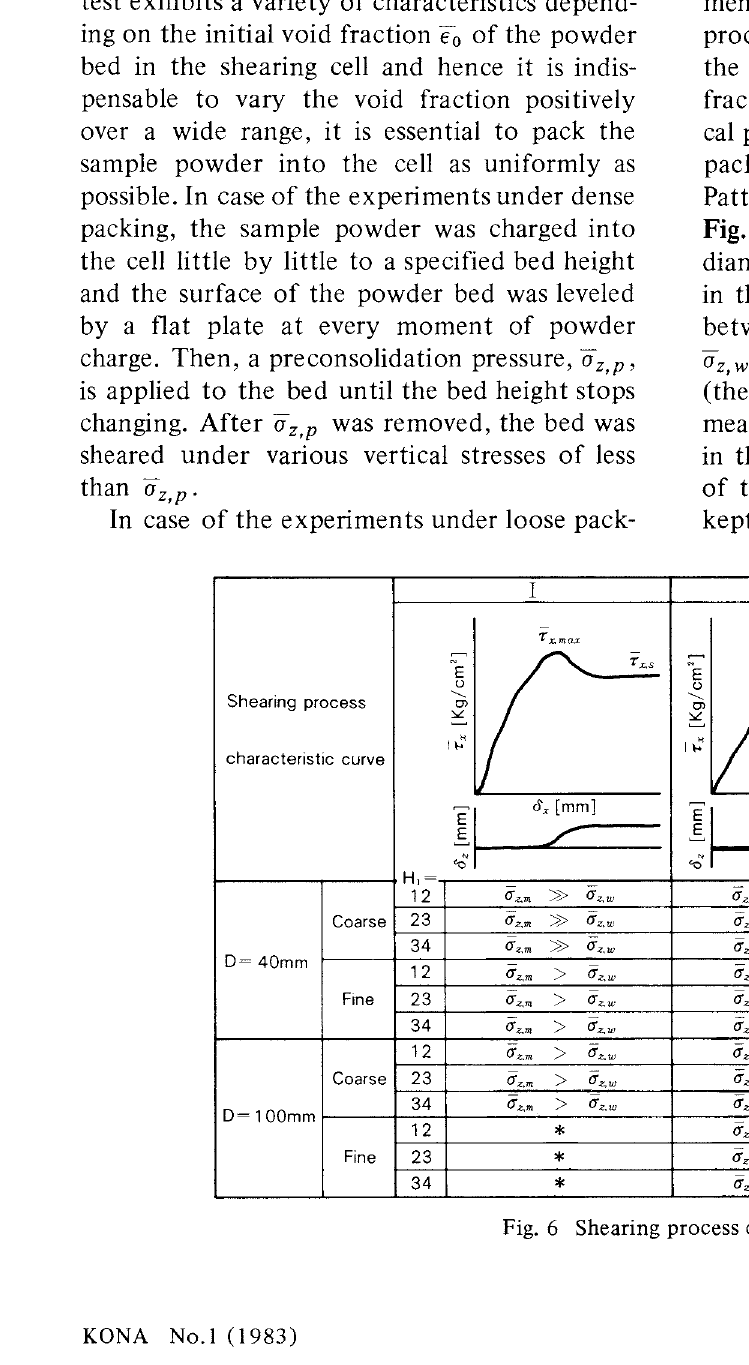
Fig. 6 Shearing process